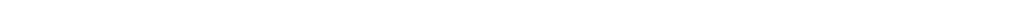
figure on next Fig. 4 Combination of three cambial variants or single cambial variant of stem cross section. A Successive cambia combined with axial vascular elements in segments and irregular conformation: Tetrastigma formosanum. B Axial vascular elements in segments combined with successive cambia: Anredera cordifolia. C External secondary vascular cylinders (empty star) combined with axial vascular elements in segments and successive cambia: Momordica charantia var. abbreviata . D Fissured stem/dispersed xylem combined: Dinetia hedyotidea. E Furrowed xylem of cambium continuity: Passiflora edulis. F Irregular in conformation combined with axial vascular elements in segments and successive cambia: Cayratia corniculata. PI, pith, PIC, pith cavity, RA, ray, PW, phloem wedges, 1st XY, first xylem, 2nd XY, second xylem, 3rd XY, third xylem, 1st PH, first phloem, 2nd PH, second phloem, 3rd PH, third phloem, 2nd VA, second vascular bundle, IC, irregular conformation, PA, parenchyma proliferation, DX, fissured stem/dispersed